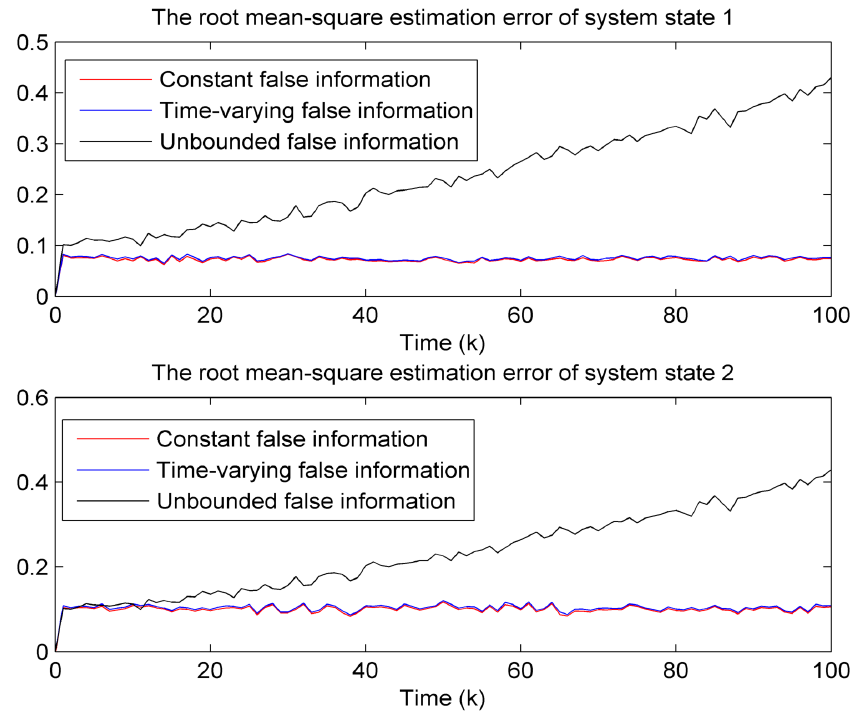
Figure 2. The root mean-square estimation error curves under different deception